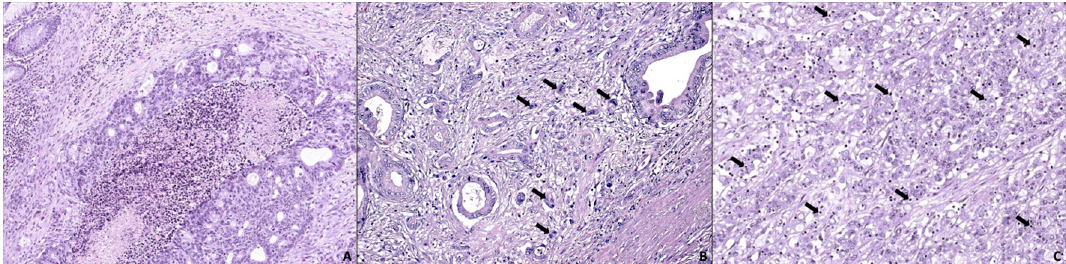
Figure 1. Differential histological features of histological subtypes of colorectal carcinoma. ( A ) Conventional carcinoma (CC) showing a cribriform gland pattern with basophilic cytoplasm, non-stratified nuclei, lobular dirty necrosis (centre) and lymphocytic infiltrates (upper-left corner). ( B ) Serrated adenocarcinoma (SAC) with typical vesicular stratified nuclei, eosinophilic cytoplasm and serrated lumen (left gland) with weak lymphocytic infiltration, tumor budding (black arrows) and desmoplastic stroma. ( C ) Colorectal carcinoma (CRC) with histological and molecular features of microsatellite instability (hmMSI-H) characterized by a medullar “solid” pattern and abundant intraepithelial tumor-infiltrating lymphocytes (black arrows) 20 × original magnification. (Source: Authors).